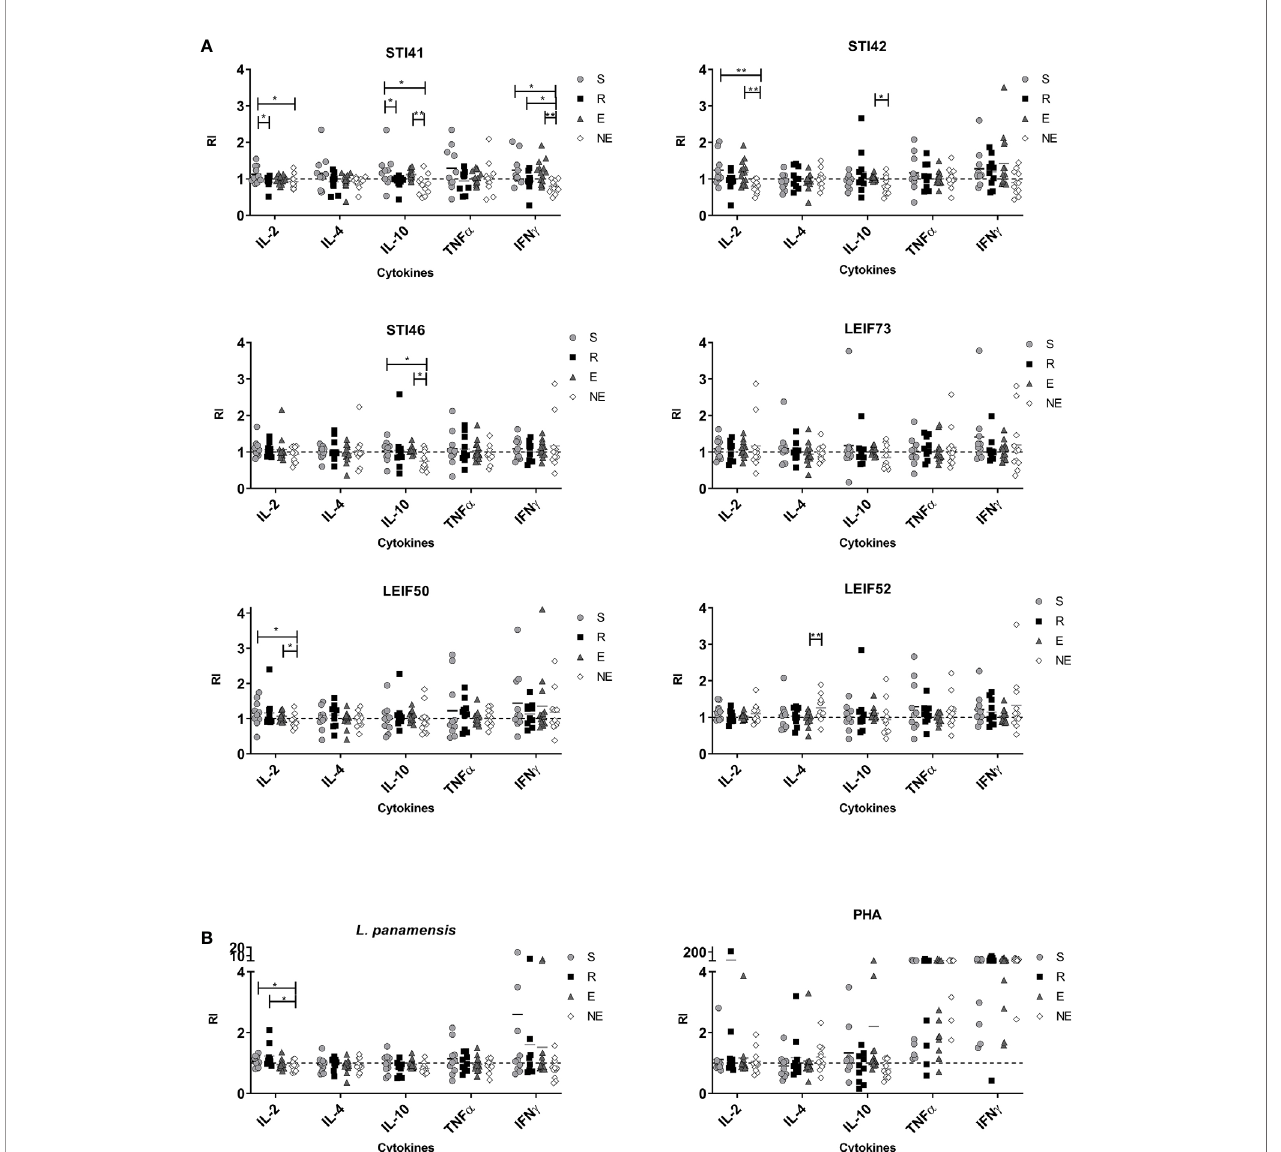
FIGURE 4 | Cytokines from lymphocytes detected in culture supernatants in S (susceptible), R (resistant), E (exposed), and NE (not exposed) groups. Cell exposed to (A) Pre-selected peptides and (B) L. panamensis or PHA. p<0.05(*), P<0.01(**). Dashed line: non-stimulated cells